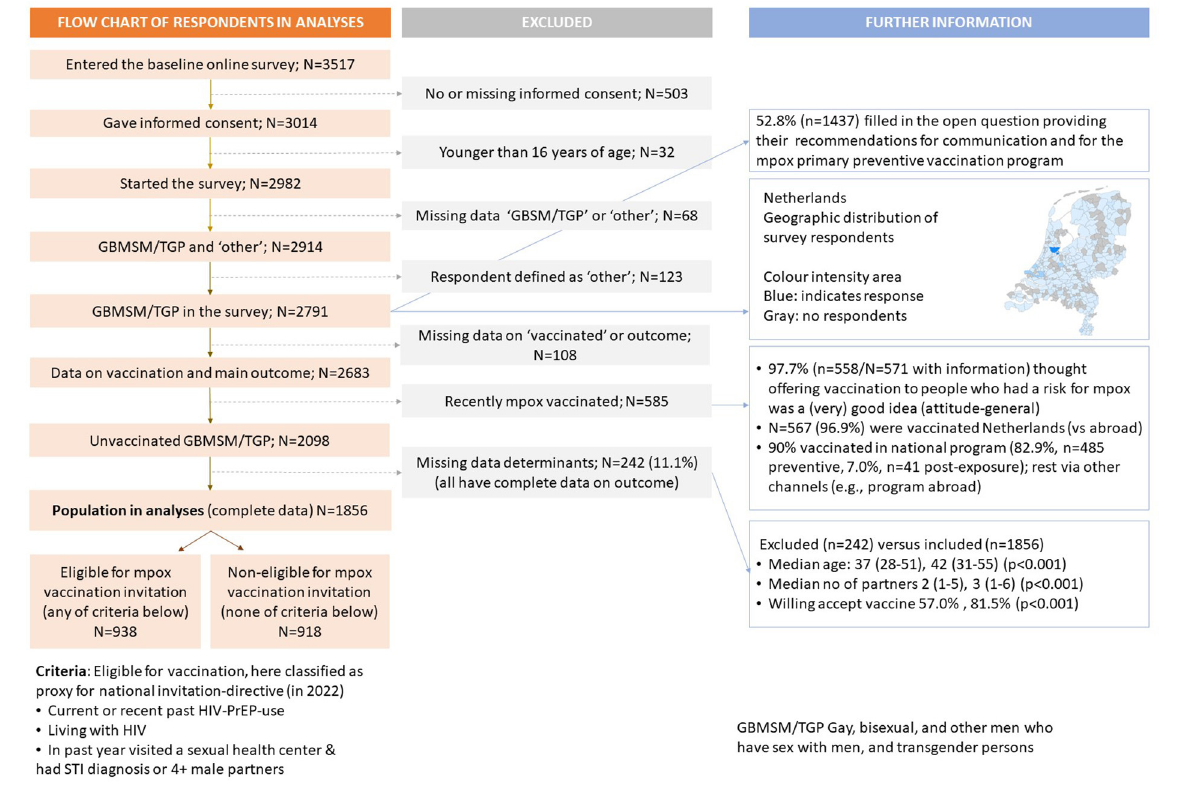
FIGURE1 Flow chart of the number of respondents in the Dutch online